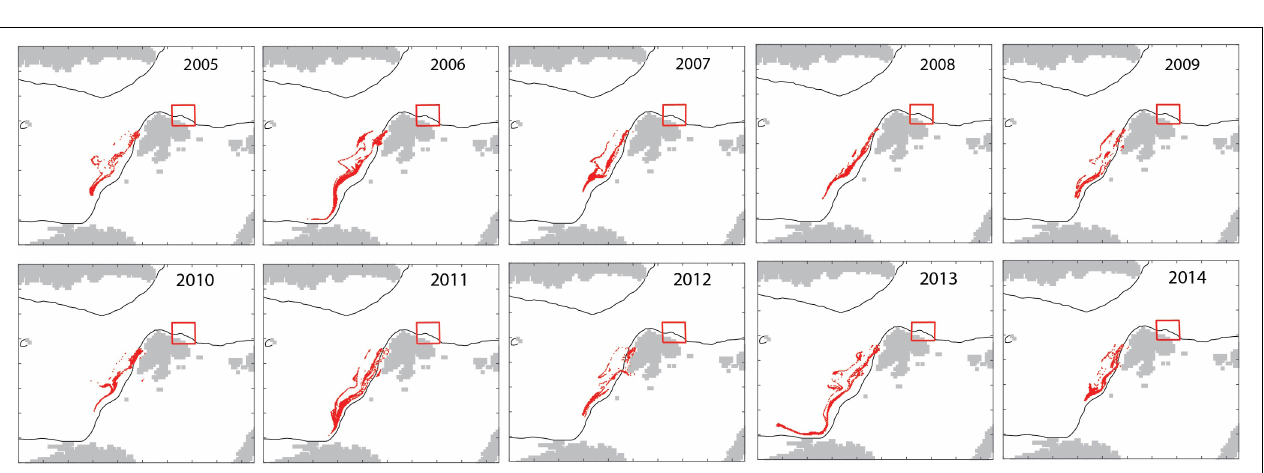
FIGURE 7 | Backtracking to April (15/4, upper left) of particles located in the box (shown) in September 1999 and forward tracking of those particles into November 1999 (bottom right).